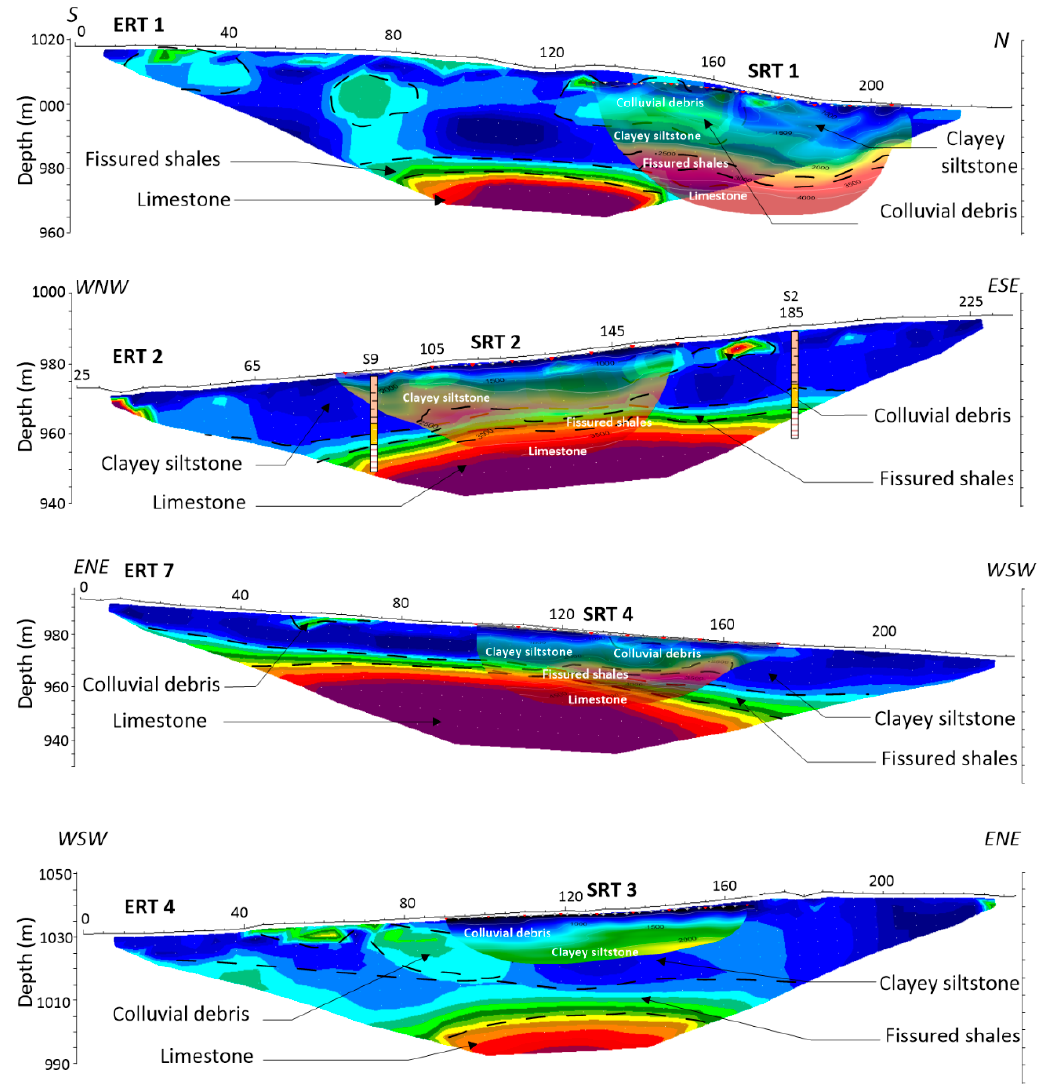
Figure 6. Overlaying of SRT, ERT and lithological logs results.